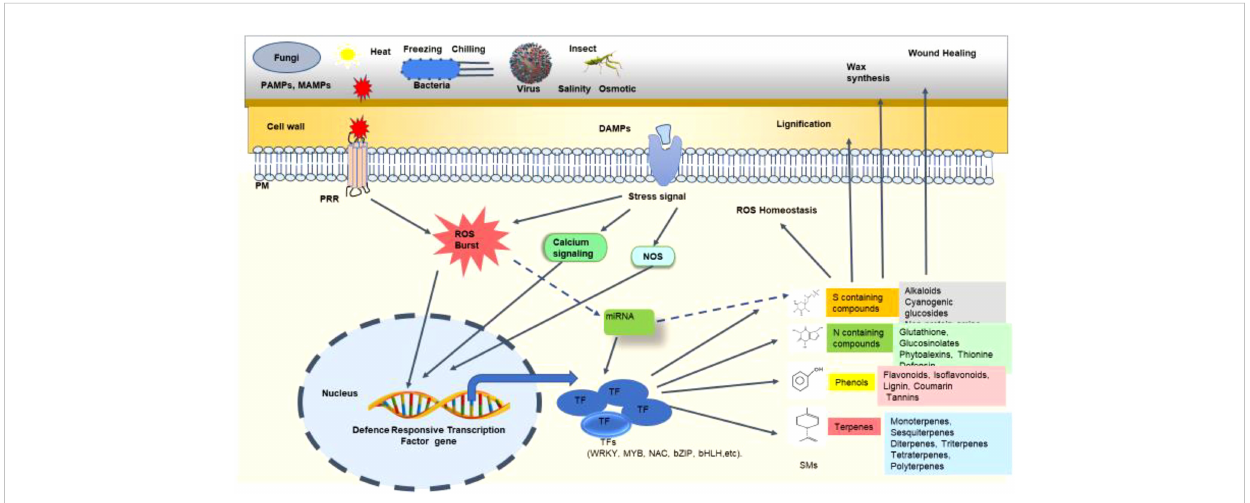
FIGURE 4 Schematic representation of the mechanism of transcription factors (TFs) regulating secondary metabolites (SMs) biosynthesis under biotic stress. At the time of biotic stress such as fungal, bacterial, viral, or insect attack, various pathogen-associated molecular patterns (PAMPs) and damage- associated molecular patterns (DAMPs) are recognized by the cell wall and membrane receptors like pattern recognition receptors (PRRs). Upon recognition, various stress signals are induced in the form of reactive oxygen species (ROS) burst, nitric oxide (NO) signalling, calcium signalling, etc. These stress signals ultimately trigger the expression of defense-responsive TF genes. These TFs like WRKY, MYB, NAC, bZIP, bHLH, etc. regulate the production of different secondary metabolites in the plant. These SMs protect the plant through ligni fi cation, wax synthesis, wound healing, ROS homeostasis, and many other mechanisms. Certain microRNAs (miRNAs) are also involved in controlling TF expression which in turn regulates SM production. The dashed line indicates the exact mechanism of SM production governed by miRNA, which is yet to be